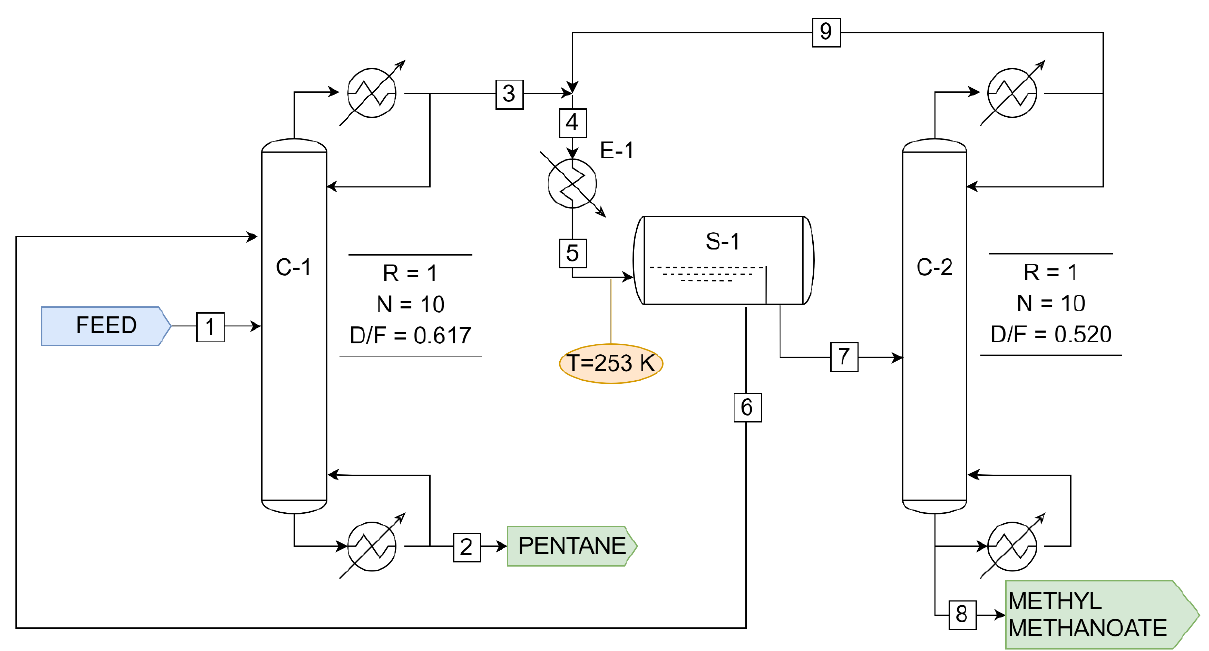
Figure 12. Flow diagram of the separation process of the binary methyl methanoate (1) + pentane (2). R = reflux ratio; D/F = distillate/feed ratio; N = number of stages.